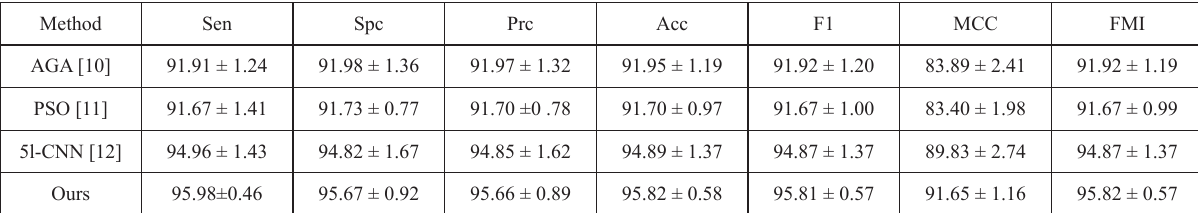
Table 10. Comparison with SOTA.